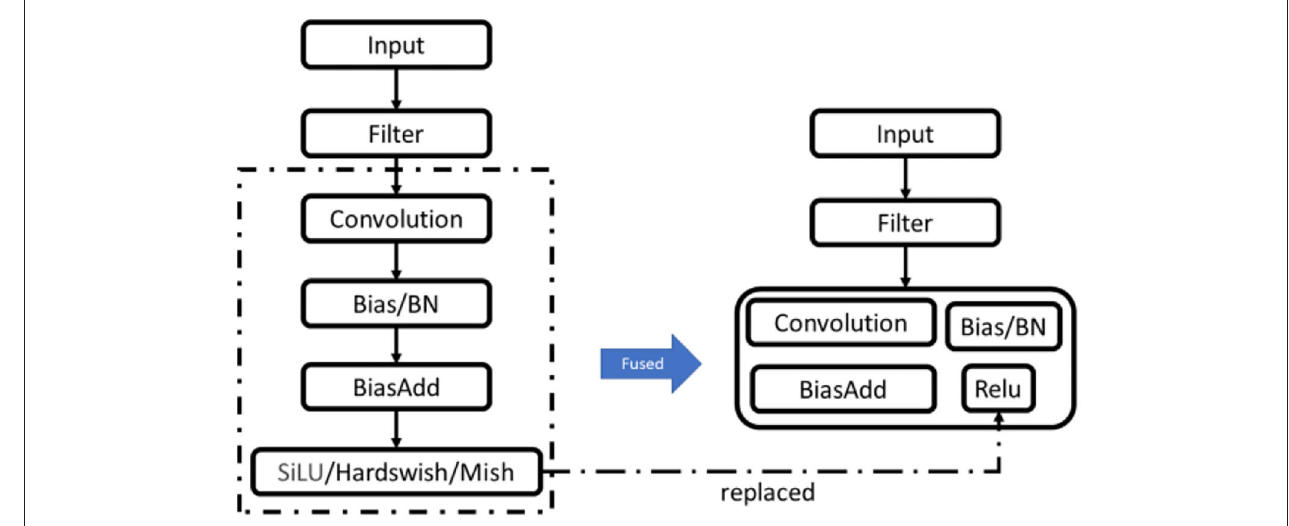
FIGURE 7 | layer fusion and data reuse.